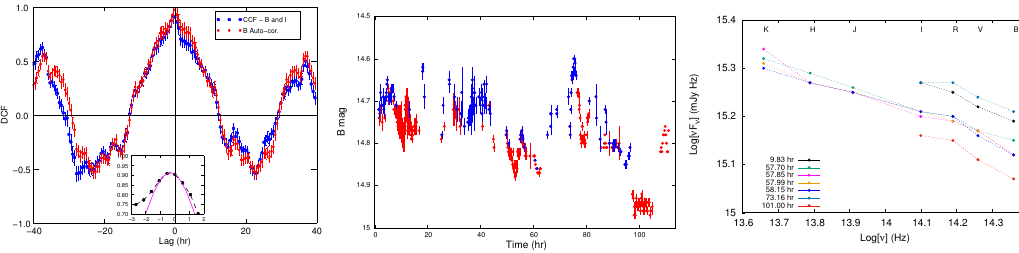
Figure 4. ( Left ): Discrete correlation function between B- and I-band light curves (blue) and auto-correlation function for B-band light curve (red). A positive lag indicates leading of B-band emission; ( Middle ): B-band light curve with blue color representing smaller B-I value (i.e., bluer color); ( Right ): The blazar spectra at the times listed on the plot